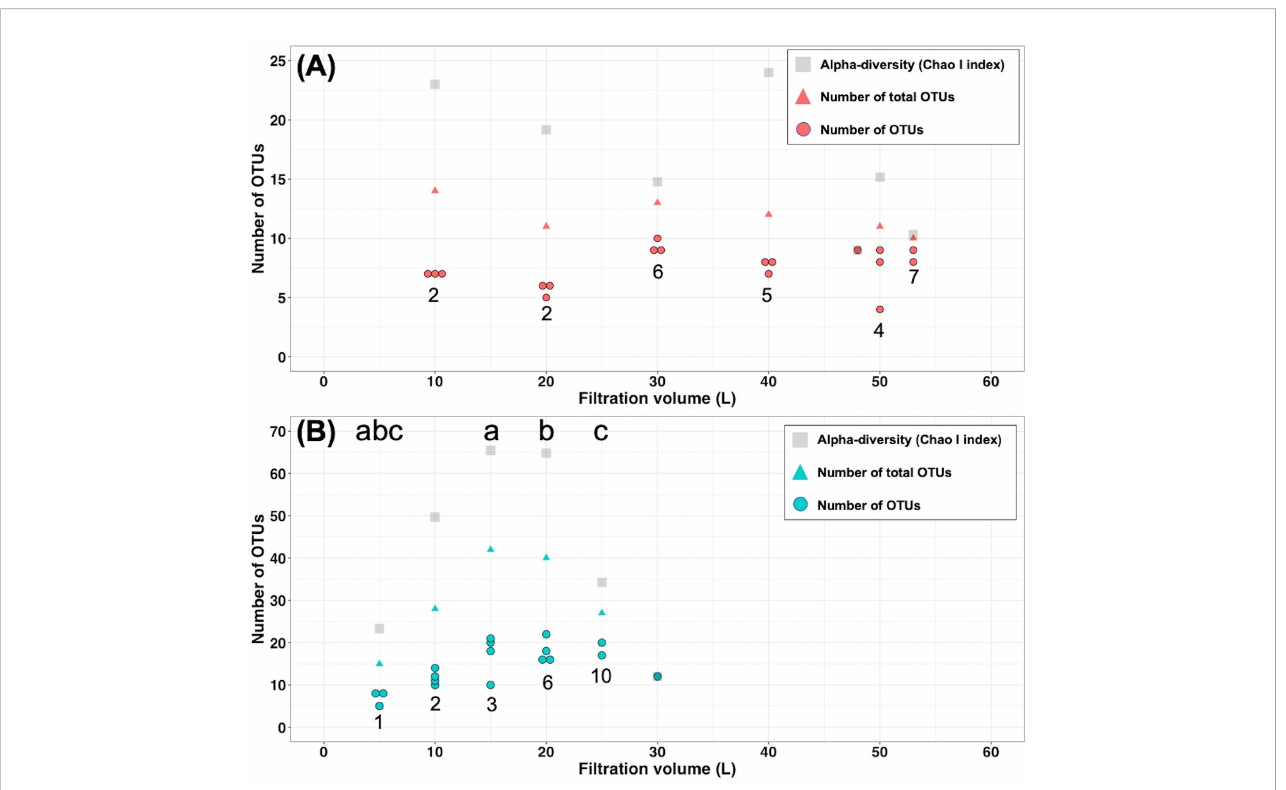
FIGURE 3 Number of fi sh OTUs identi fi ed from different fi ltration-volume samples in (A) Akazawa, and (B) Yaizu. Circles, triangles, and squares indicate the number of OTUs, number of total OTUs, and alpha-diversity (ChaoI index), respectively. The numbers below circles indicate the number of shared OTUs between all replicates. There is a signi fi cant difference in the number of OTUs between samples given the same alphabet based on Dunnett ’ s test (p < 0.05).